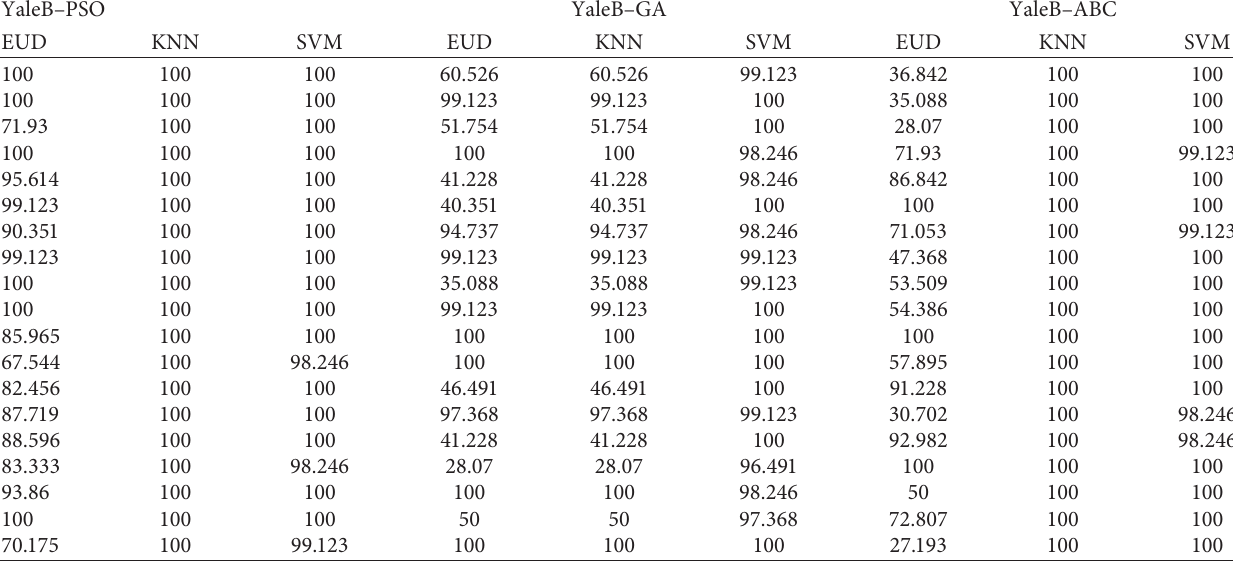
Table 8: YaleB experiment results for PSO, GA, and ABC using EUD, KNN, and SVM classifiers.